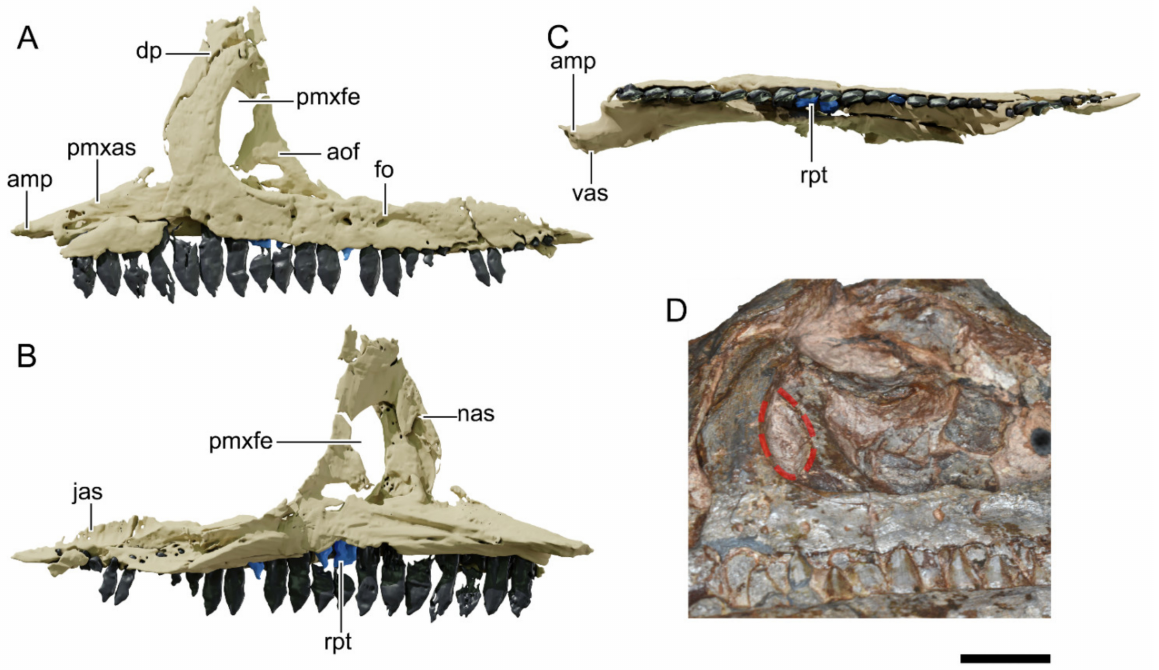
Figure 10. Digital reconstruction of the left maxilla of NHMD 164741. ( A ) Lateral view. ( B ) Medial view. ( C ) Ventral view. ( D ) Photograph of the left maxilla highlighting the promaxillary fenestra. Abbreviations: amp, anteromedial process; aof, antorbital fossa; dp, dorsal process; fo, foramen; jas, articular surface for the jugal; nas, articular surface for the nasal; pmxas, articular surface for the premaxilla; pmxfe, promaxillary fenestra; rpt, replacement tooth; vas, articular surface for the vomer. Scale bar = 20